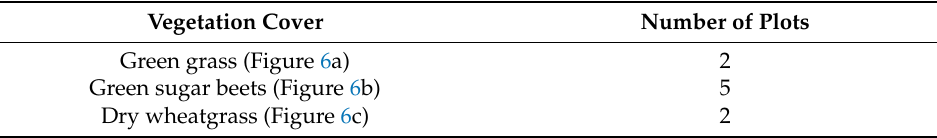
Figure 6. Three of the spectral field plots with green grass ( a ), green sugar beets ( b ), and dry wheatgrass ( c ). Table 3. Overview of the spectral field